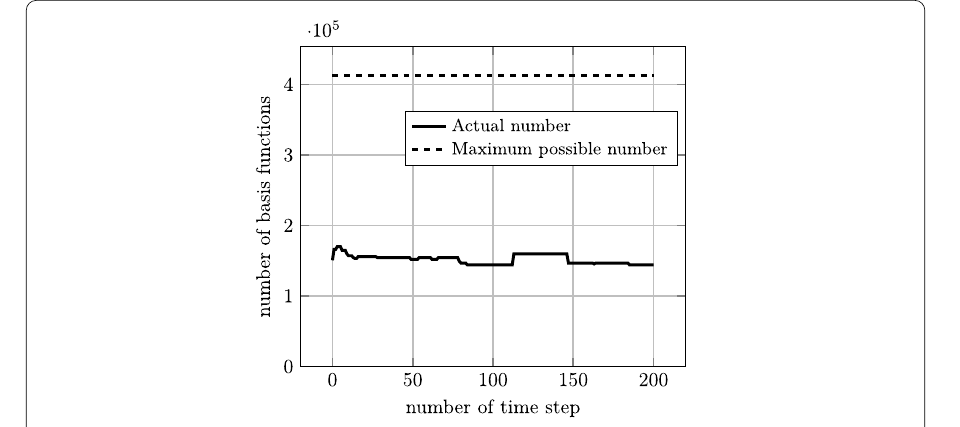
Figure 14 Number of used basis functions for the AQ3D in every time step. The dashed line indicates the maximum possible number of basis functions with the corresponding value of j